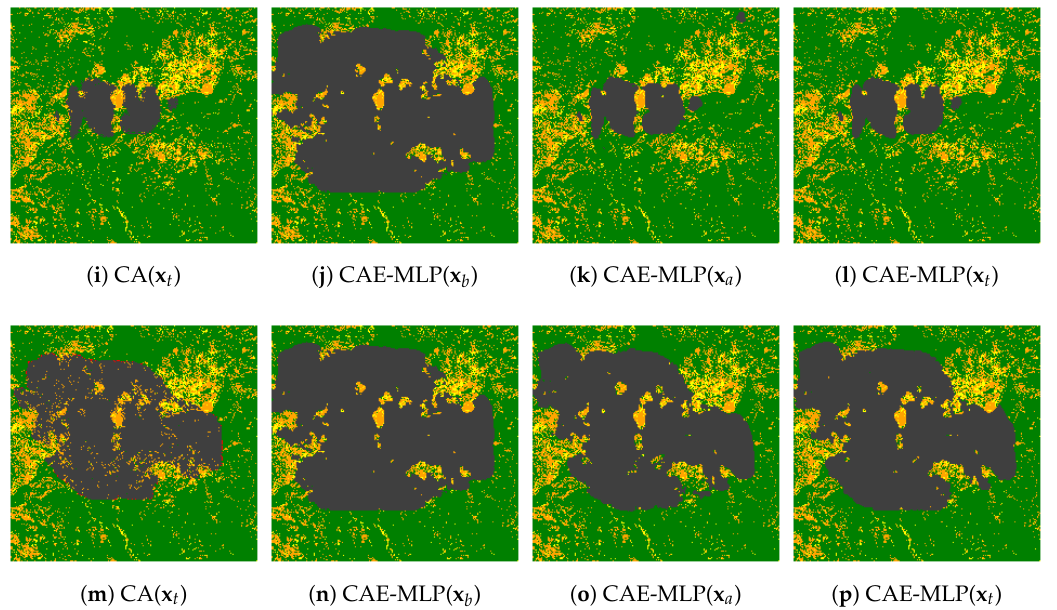
Figure 9. Machine learning (DL) prediction of burned area at day 6 for both fire events (Chimney ( a – h ) and Ferguson ( i – p )) using original ( x b ) and assimilated ( x a ) parameters compared to CA simulations (considered as ground truth here) for 2 examples in the test dataset.